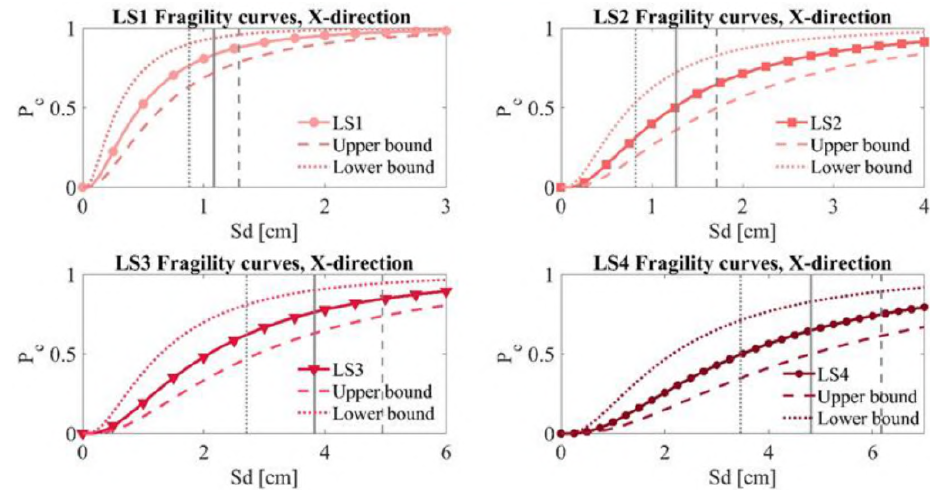
Figure 16. Mean, upper and lower fragility curves for the four limit states of interest, in the X-direction.